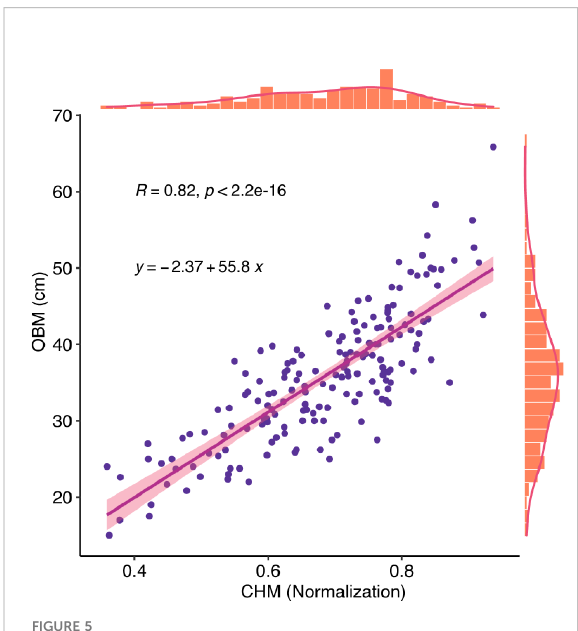
FIGURE 5 Correlation between CHM and Observation. CHM is crop height model, it is the plant height estimated